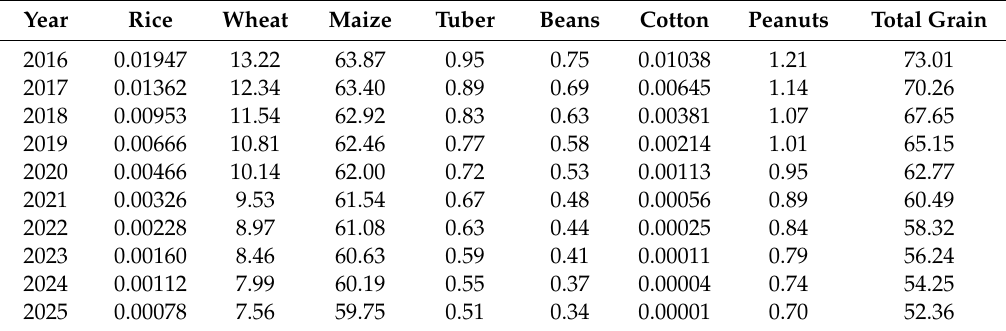
Table 7. Prediction of crops yield (×10 4 t) from 2016 to 2025 with GM (1,1) model.